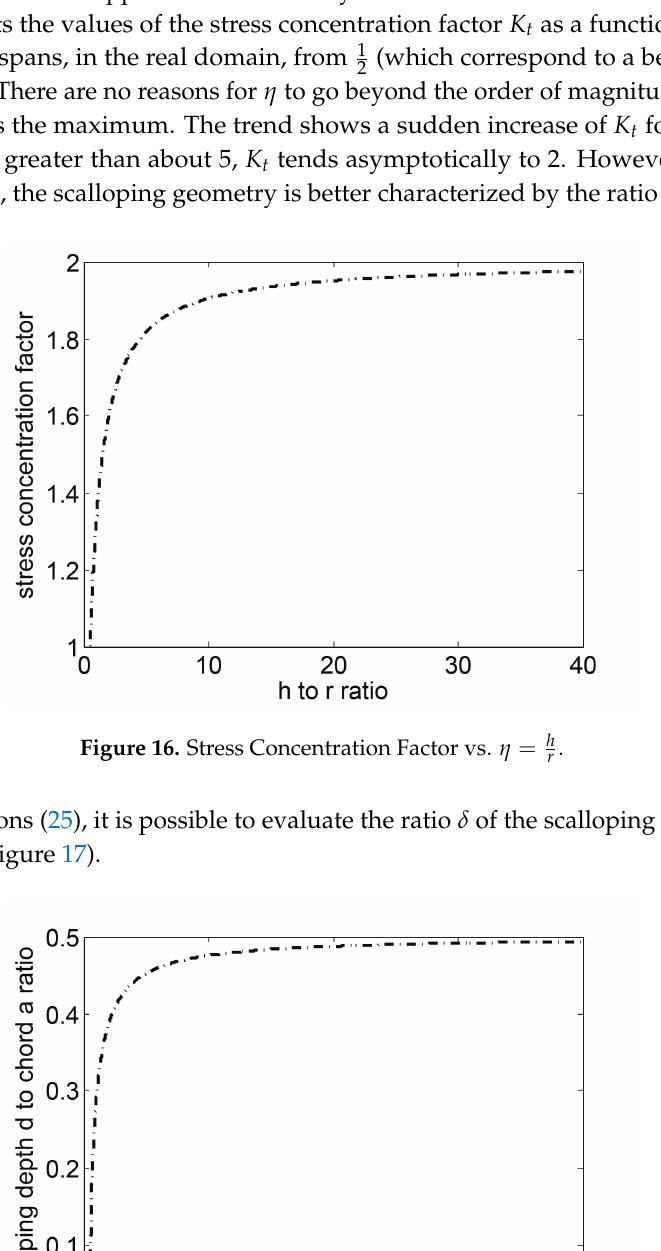
Figure 17. Ratio δ of the scalloping dept d to chord a as a function of η